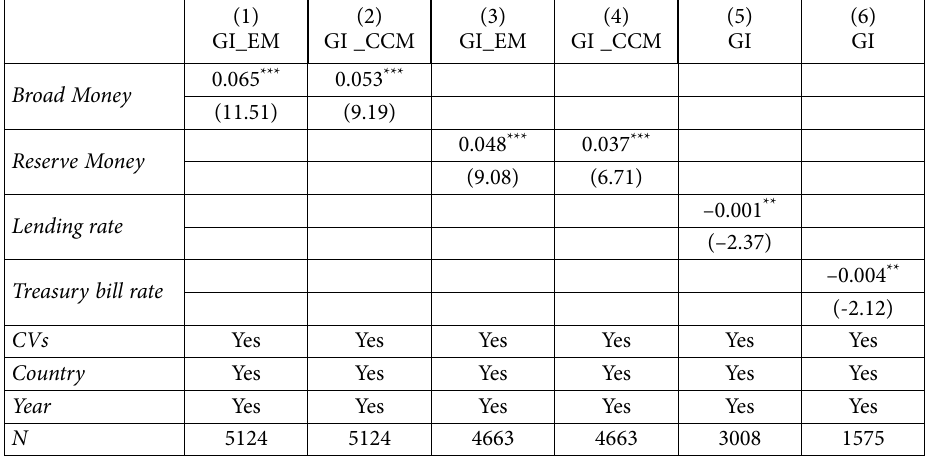
Table 4. Alternative innovation proxies and explanatory